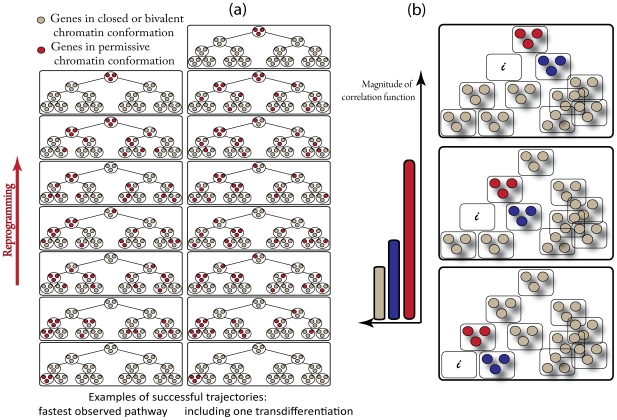
Simulations of a model where each gene module regulating a cellular identity consists of three different genes.(a) In this (similar to the previous) model, individual genes do not interact with each other. Rather modules interact with each other when all of the proteins in a module are expressed. Since reprogramming factors change the epigenetic state of randomly chosen individual genes, several (here: at least three) genes have to be changed to open chromatin status at the same time in order to allow a whole module to be able to express proteins. Examples of simulated trajectories show activation of genes of unrelated lineages during successful reprogramming. Simulations are performed with parameter values F = 2000; J = 3000; G = 25; H = 40; a = 0; b = 0.3. (b) If population averaged expressions of genes during reprogramming can be measured, one can compute a 4-point correlation function (see Eq. 1). This correlation function describes the probability of activation of a given gene after the master regulatory gene module, i, was silenced. Then all the genes can be grouped in three groups as our simulation indicates. Thus, the genes defining the most likely paths to reprogramming can be identified as the ones with the highest magnitude of this correlation function. The correlation function was computed by averaging over all successfully reprogrammed trajectories. The colors correspond to the magnitude of the correlation function (as shown on the left).